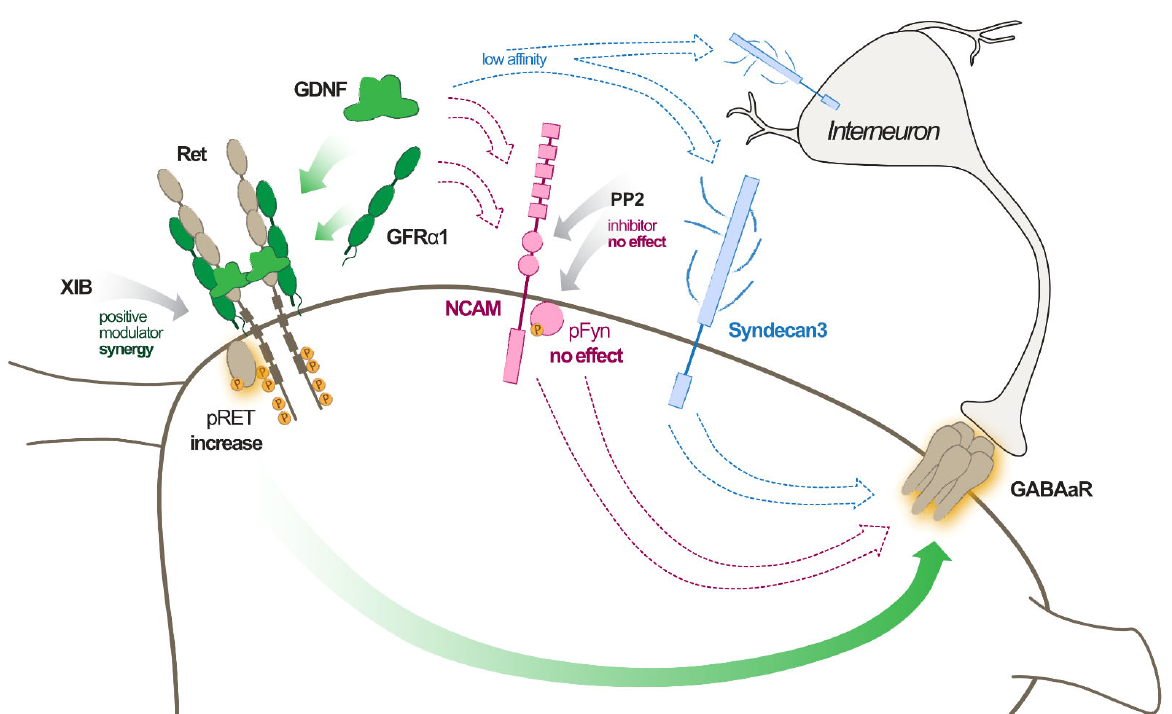
Figure 9. Graphical illustration of likely GDNF mechanism of action leading to increased GABA A R effect on pyramidal neurons in the hippocampus.